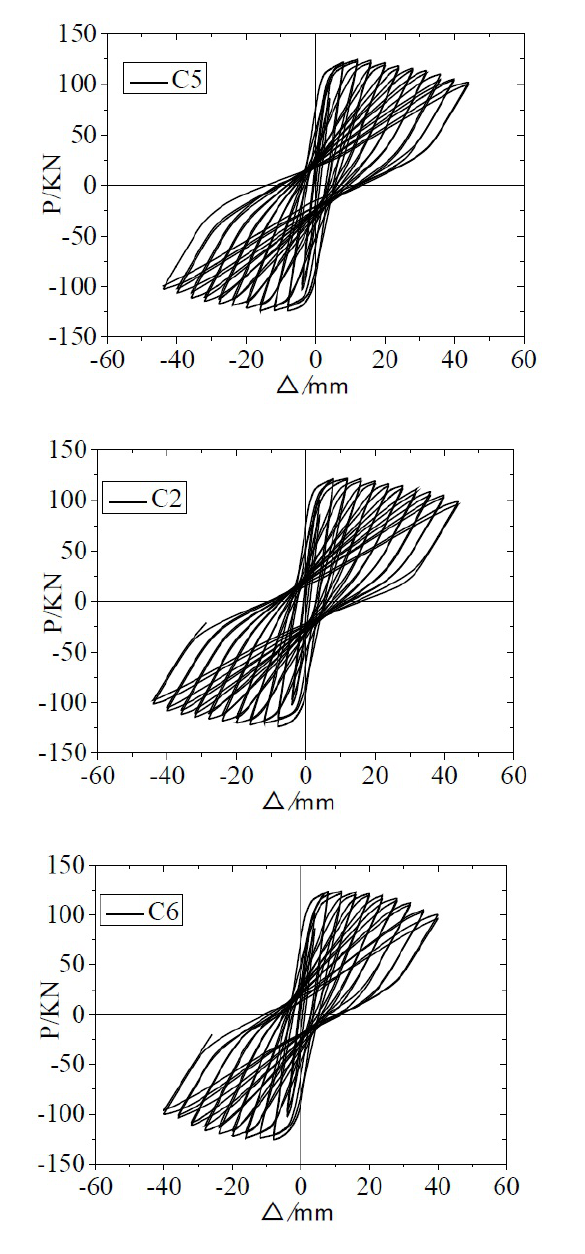
Figure 19: Hysteretic curves of different stirrup spacings (1) Influence of Reinforcement Layer Number on TRC Columns The accumulated energy dissipation curves of spec- imens with different reinforcement layers are shown in Fig. 22(a). The total energy dissipations of reinforced columns (C1, C2, C3 and C4) were 26.90%, 79.81%, 87.54% and 86.13% higher than that of unreinforced columns (C0), respectively. It can be seen that TRC reinforcement within